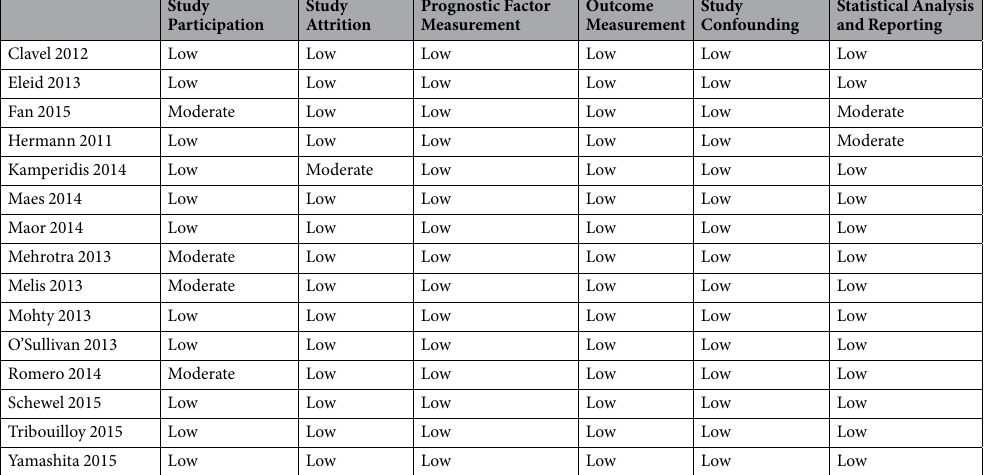
Table 3. Risk of bias assessment for included studies.